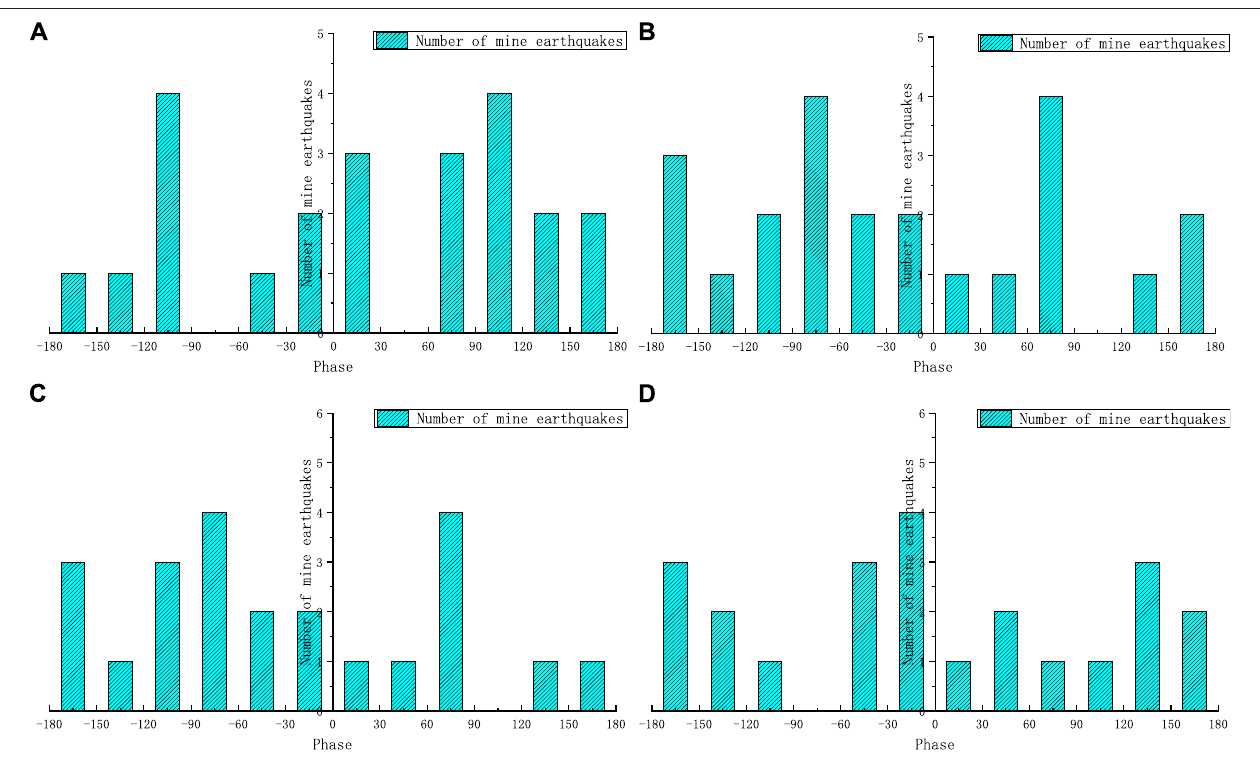
FIGURE 8 | Statistical histogram of the mine earthquake M L > 1.5 frequency.